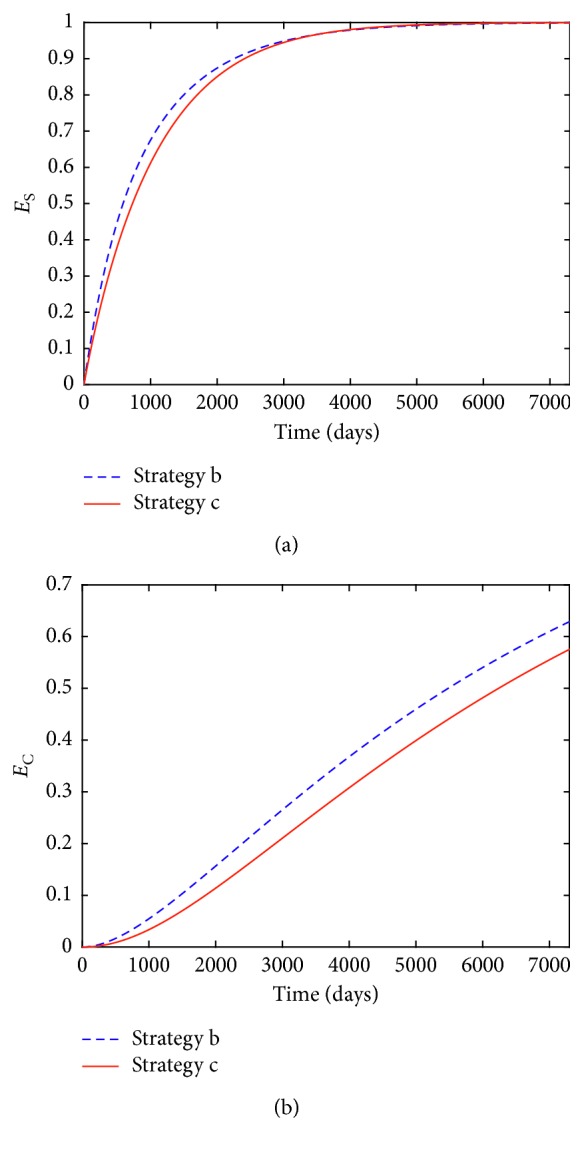
(a) Efficacy functions of EkS(t) (k = b and c) for strategies b and c; (b) efficacy functions of EkC(t) (k = b and c) for strategies b and c.